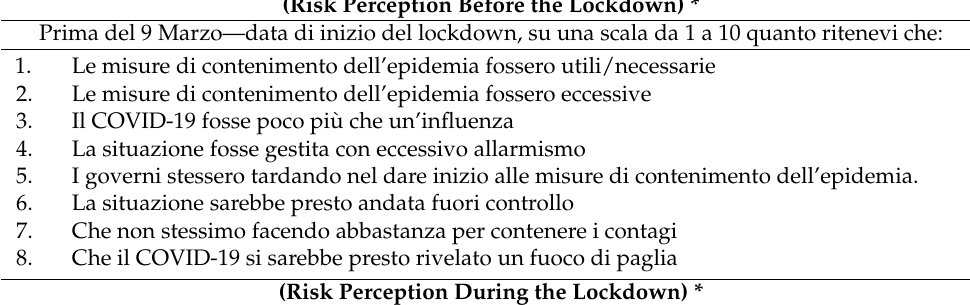
Table A1. List of the items included in the questionnaire. (Risk Perception Before the Lockdown)